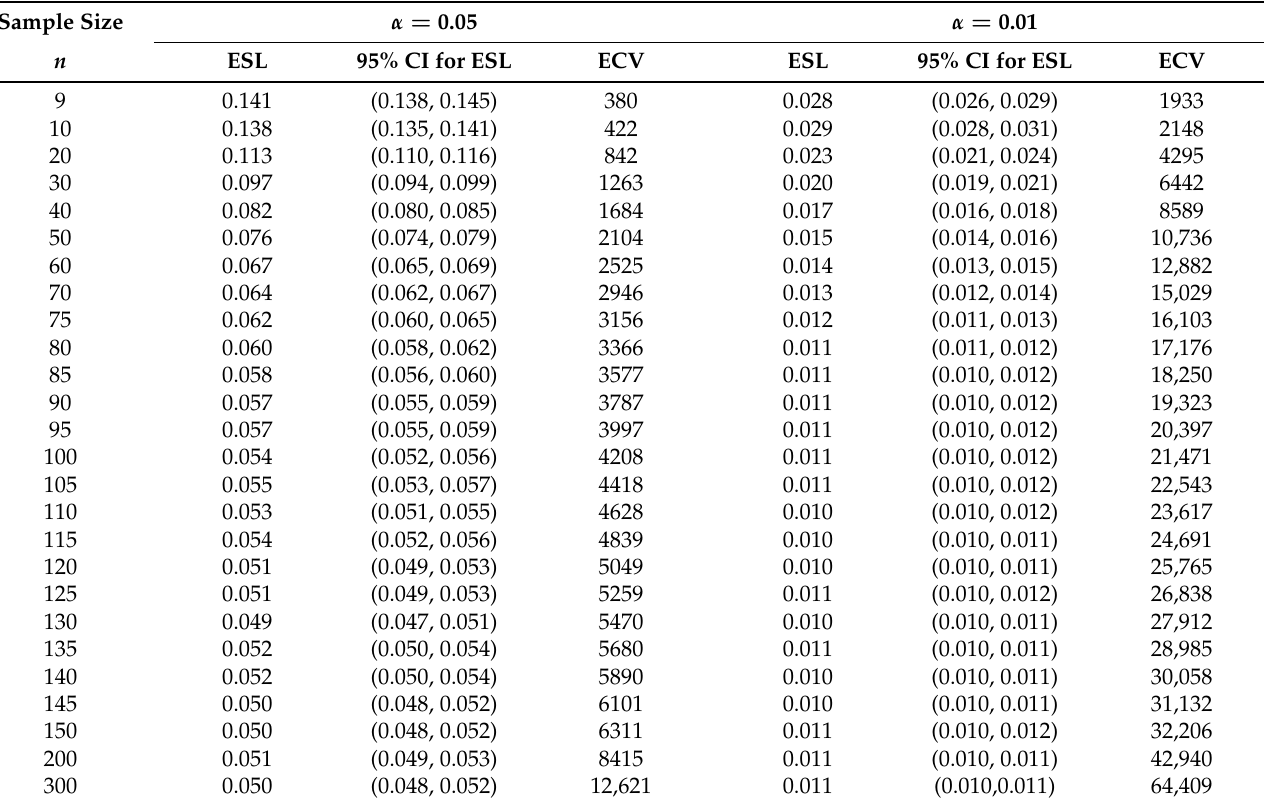
Table 3. ESLs with asymptotic 95% CIs of the supremum test statistic for various sample sizes when d = 8 and the NSLs are equal to 0.05 or